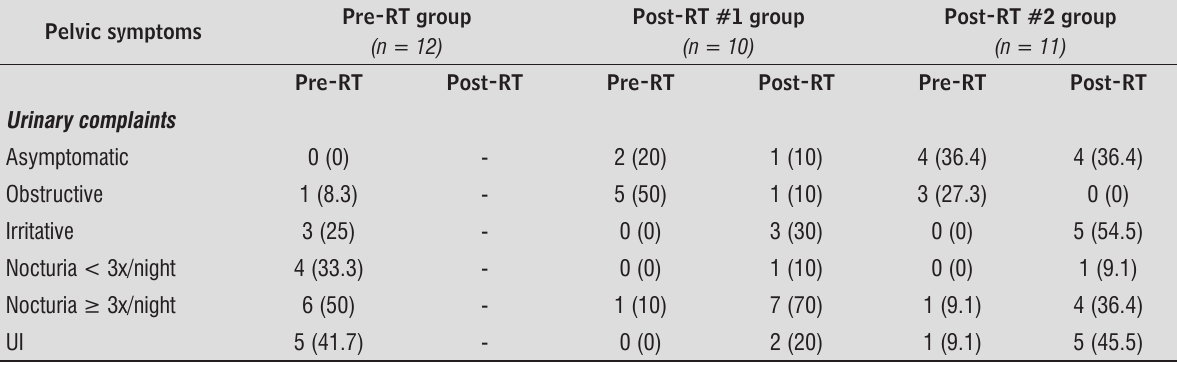
Table 3 - Pre- and post-radiotherapy pelvic symptoms [ n ( % ) ] Pelvic